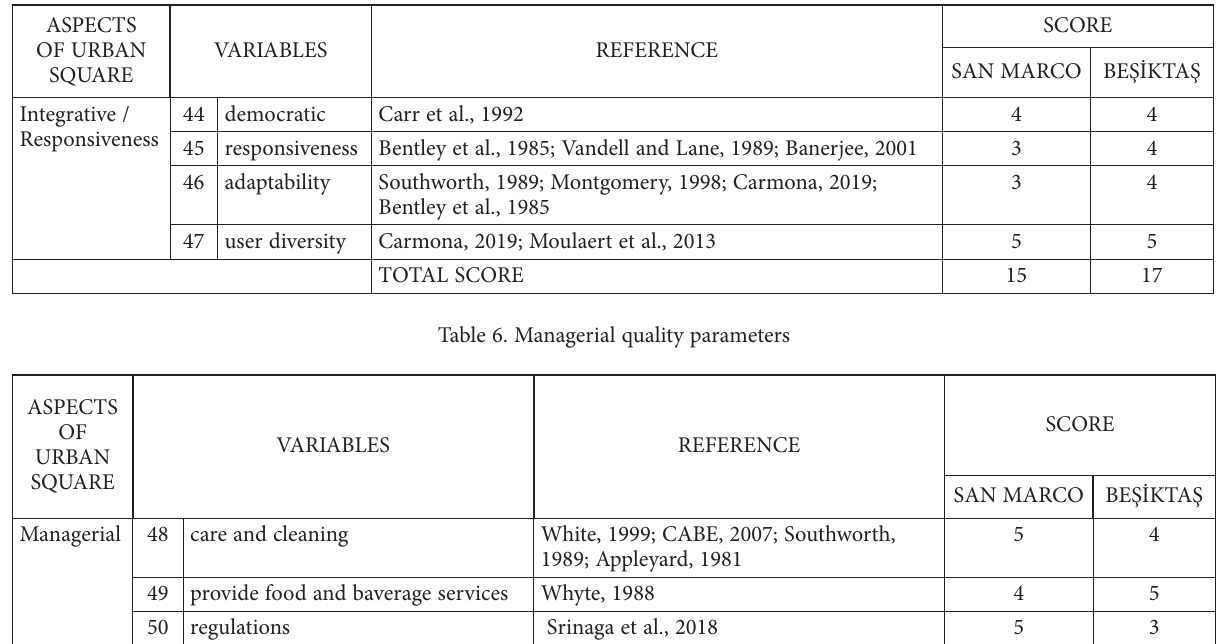
Table 5. Integrative / Responsiveness quality parameters